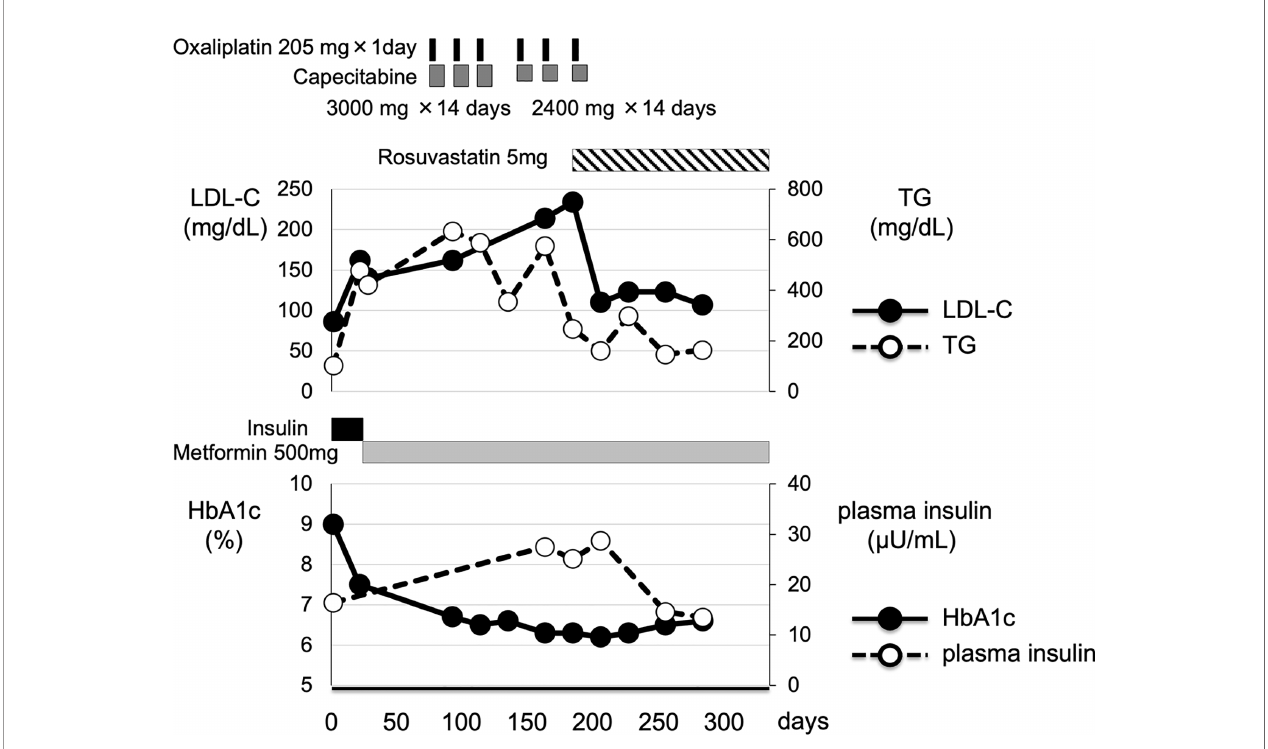
FIGURE 1 | Clinical time course of clinical parameters in this subject. After emergency surgery, this patient underwent 6 courses of chemotherapy including capecitabine. After emergency surgery, she was treated with 500 mg of metformin for diabetes mellitus. In addition, through the chemotherapy including capecitabine, her plasma insulin level and LDL-cholesterol level were markedly elevated. And then, she was treated with 5 mg of rosuvastatin, one of the HMG-CoA reductases, for the treatment of dyslipidemia. Her plasma insulin and LDL-cholesterol level were markedly